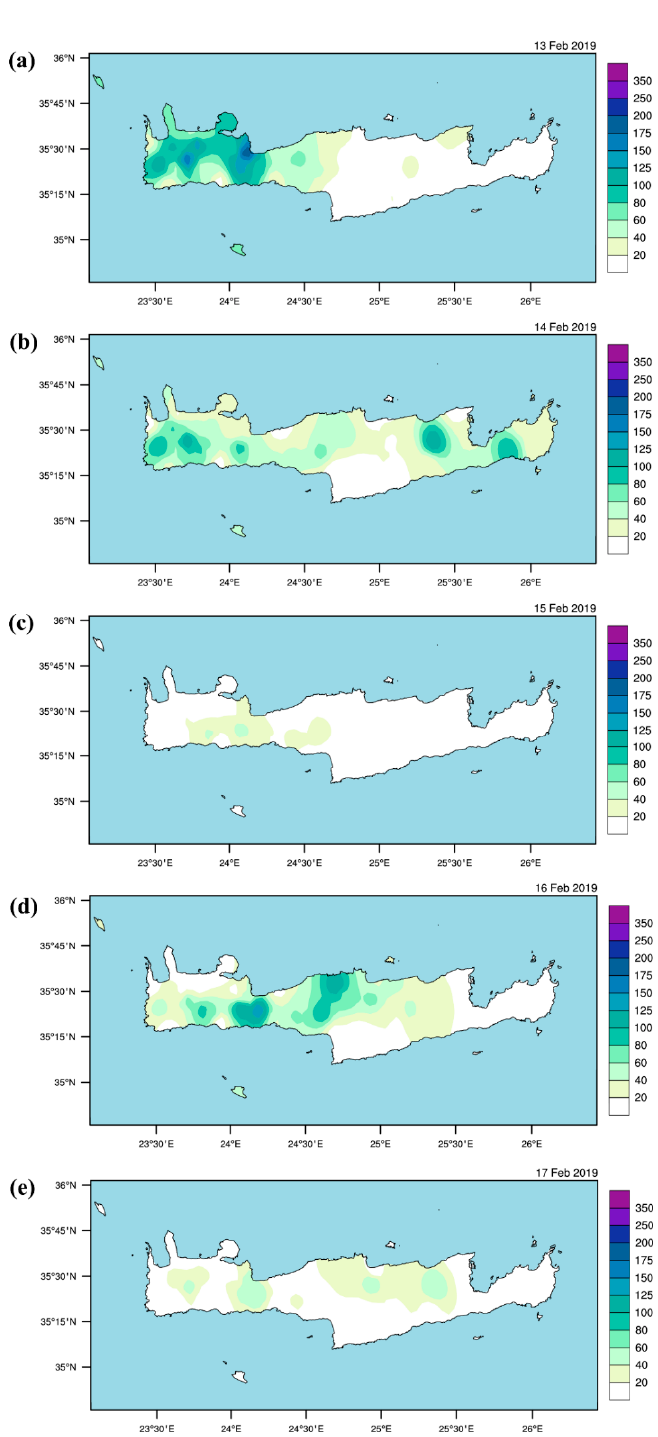
Figure A1. Total accumulated rainfall in Crete during the Chioni storm for the periods spanning ( a ) from 0000 UTC 13 February to 0000 UTC 13 February 2019 (24 h), ( b ) from 0000 UTC 14 February to 0000 UTC 14 February 2019 (24 h), ( c ) from 0000 UTC 15 February to 0000 UTC 15 February 2019 (24 h), ( d ) from 0000 UTC 16 February to 0000 UTC 16 February 2019 (24 h), and ( e ) from 0000 UTC 17 February to 0000 UTC 17 February 2019 (24